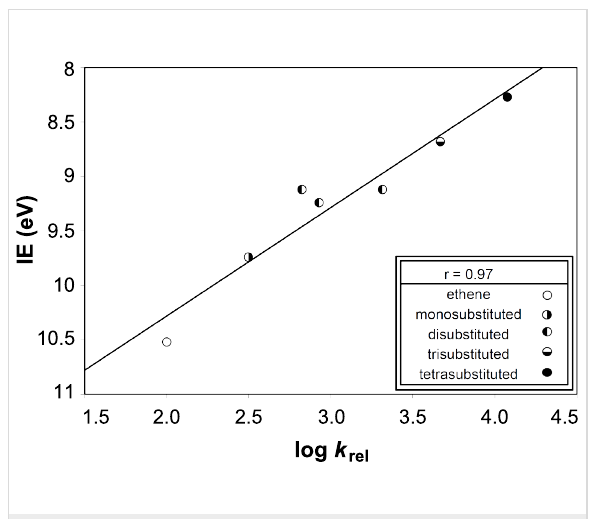
Figure 6: Plot of log k rel values for PhSCl addition to alkenes versus their IEs. Data are from Table 6.